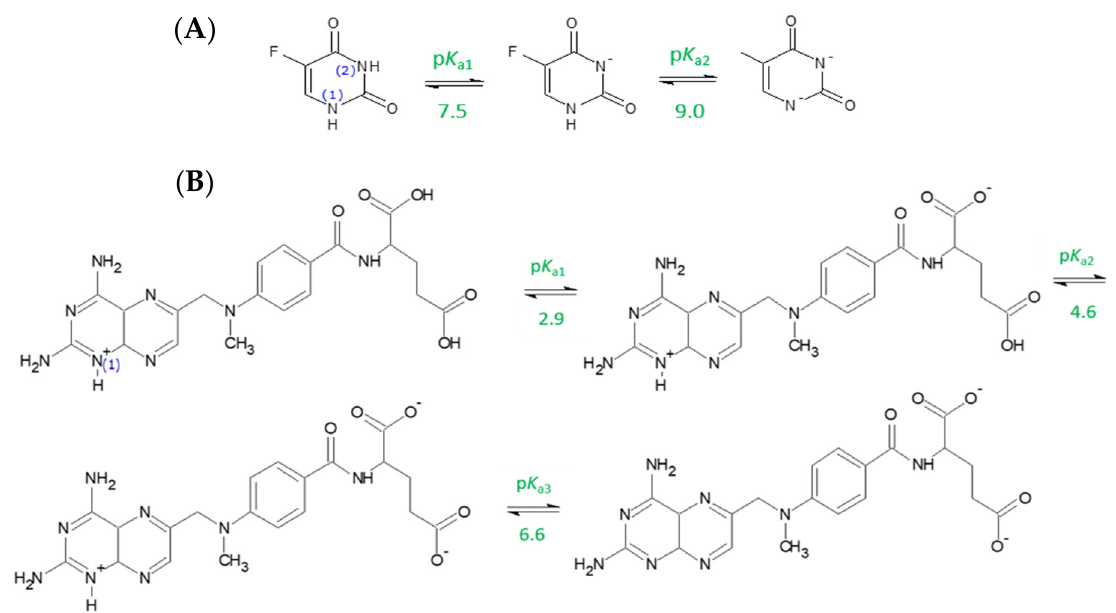
Figure 2. Acid–base equilibrium of 5-FU ( A ) and MTX ( B ) [43]. Briefly, two pKa values of 5-FU (pK a1 = 7.53, pK a2 = 9.01) lead to two steps of dissociation. We have observed that at pH ~6, 5-FU starts to dissociate to monoanionic species. At pH equal to pK a1 , 50% of 5-FU molecules exist as neutral species, whereas 50% exist as monoanionic molecules. The dianionic species of 5-FU is formed at the pH that corresponds to pK a2 (9.01); however, above a pH of 9.5, the dianionic form is predominant [43].